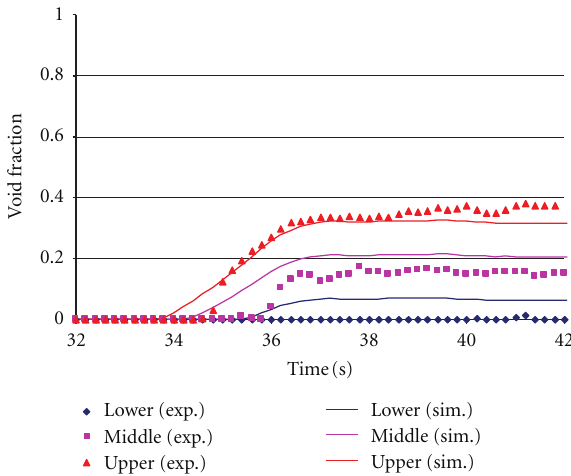
Figure 13: Void fraction comparison for power increase transient.